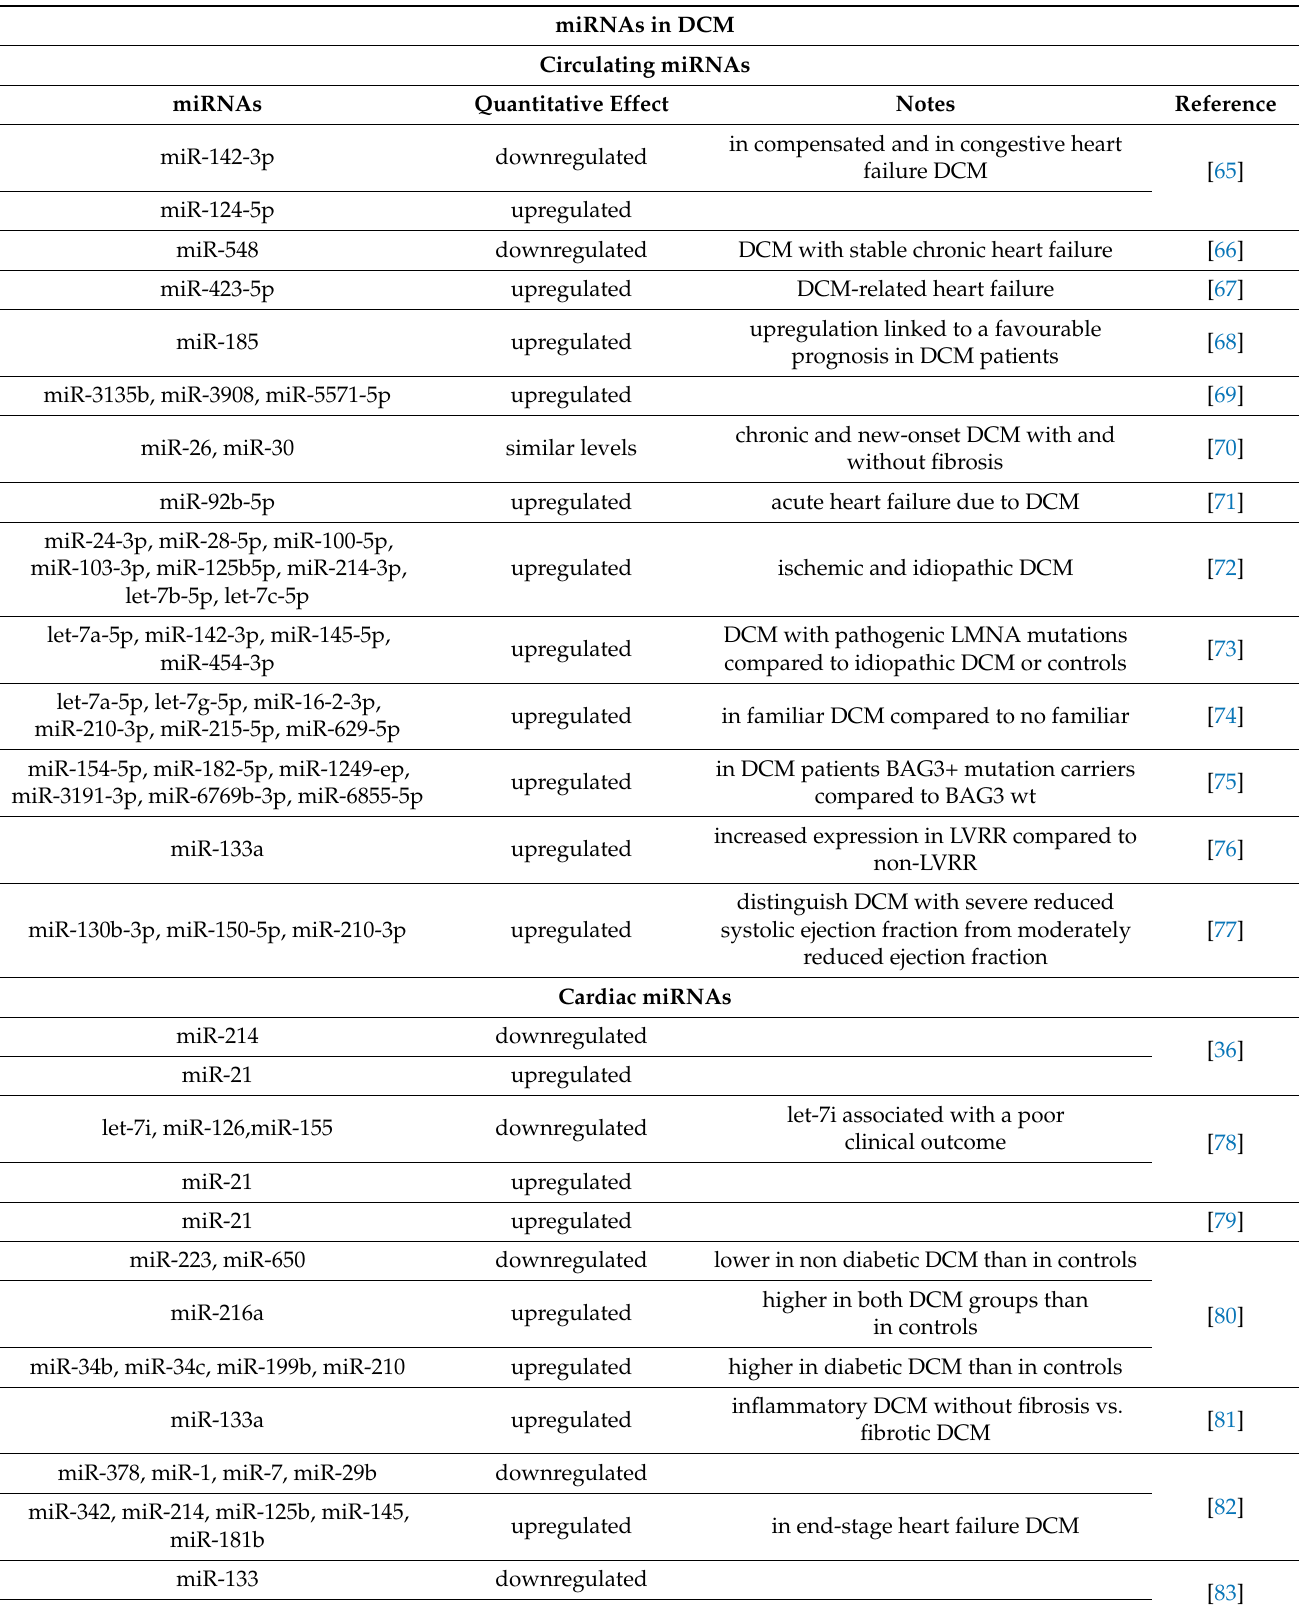
Table 3. Summary of miRNAs potentially involved in human